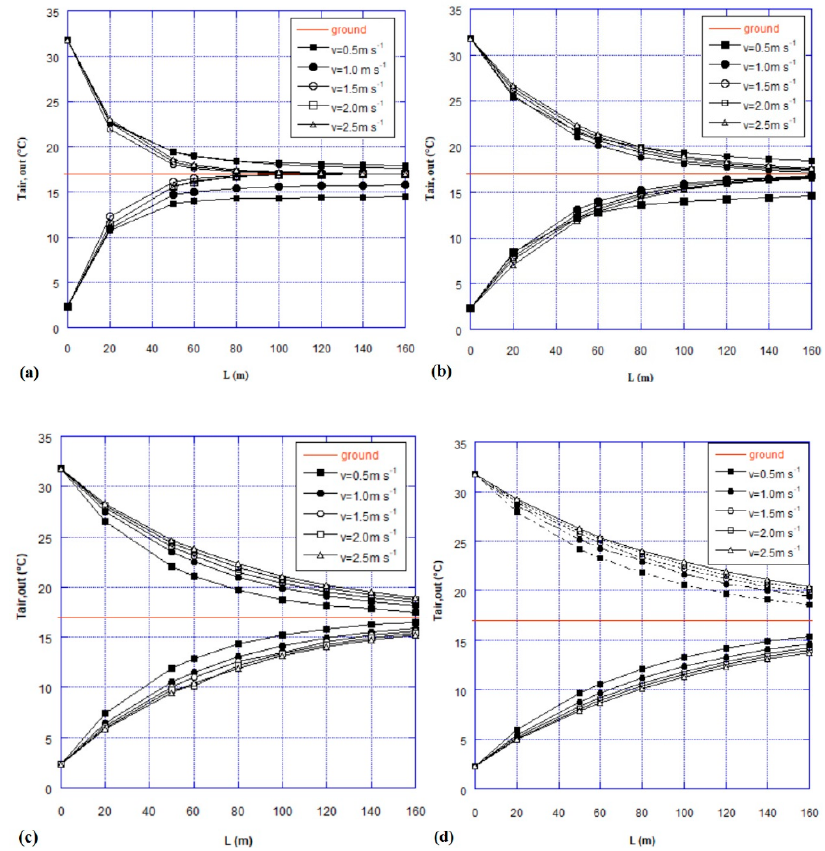
Figure 8. Outlet air temperature vs length parametrized for air velocity while the diameter is: ( a ) 0.1 m; ( b ) 0.2 m; ( c ) 0.3 m; ( d ) 0.4 m.